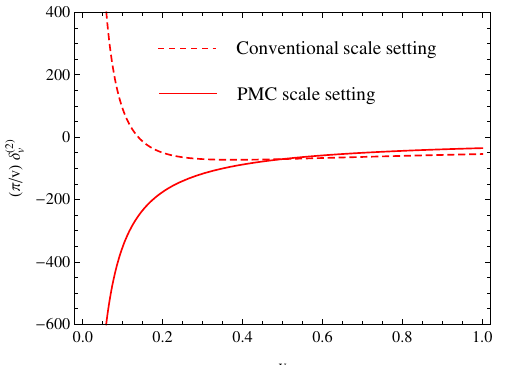
Figure 6. The behavior of the Coulomb terms in the V-scheme for the b quark pair production, where ( 2 ) = ( δ ( 2 ) | + δ ( 2 ) | ) for conventional scale setting, and for PMC scale setting, δ ( 2 ) δ v v , n f V V n f v , in The one-loop correction coefficients δ ( 2 ) ( 2 ) ( 2 ) cients δ , δ have the same form in QCD and QED, with only some replace- v , n f , and δ h , n f v 2 ments for the color factors, i.e., C A = 3, C F = 4/3 and T R = 1/2 for QCD and C A = 0, C F = 1, and T R = 1 for QED,